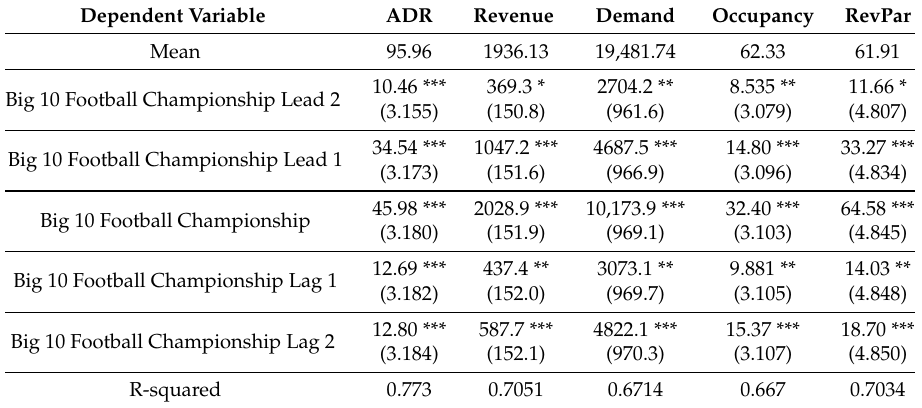
Table 8. The impact of Big 10 football championship and basketball tournament games on the hotel industry.